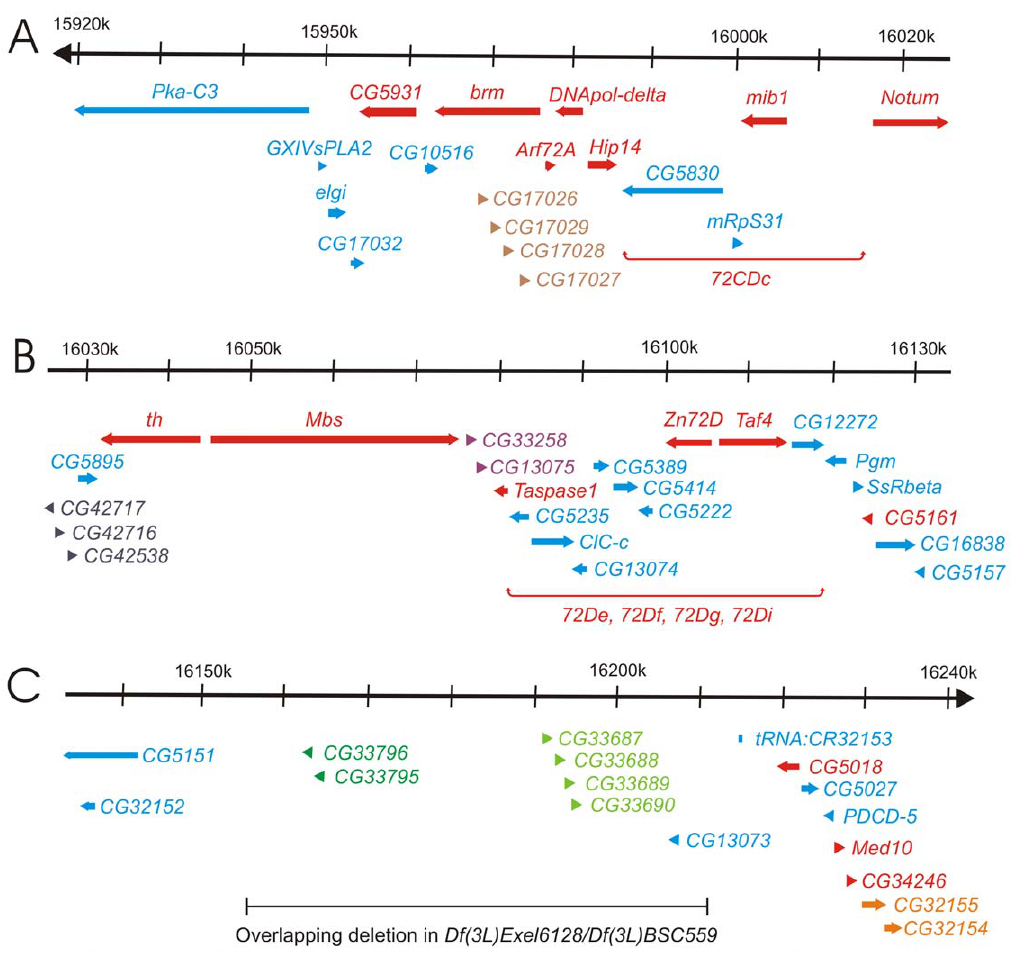
Figure 2. Molecular map of the genomic region deleted in Df(3L)th102 . The approximately 320 kb of genomic DNA (from 3L: 15918k to 16240k, Release 5.23) is broken into three parts (A, B, and C), and is represented by the horizontal black arrows at the top of each part. The annotated transcription units are represented by colored thick horizontal arrows. The essential transcription units are red and orange. The clusters of transcription units encoding related proteins are brown (the cluster in 2A), grey (the cluster in 2B), purple (the cluster in 2B), dark green (the cluster in 2C), light green (the cluster in 2C), and orange (the essential genes CG32155 and CG32154 in 2C). All other transcription units are blue. The two regions that include the five essential genes ( 72CDc , 72De , 72Df , 72Dg , and 72Di ) for which the transcription units have not been identified are indicated by red horizontal brackets below the candidate transcription units. The DNA missing in flies trans-heterozygous for the overlapping deletions Df(3L)Exel6128 and Df(3L)BSC559 is indicated by the horizontal black bar at the bottom of 2C.